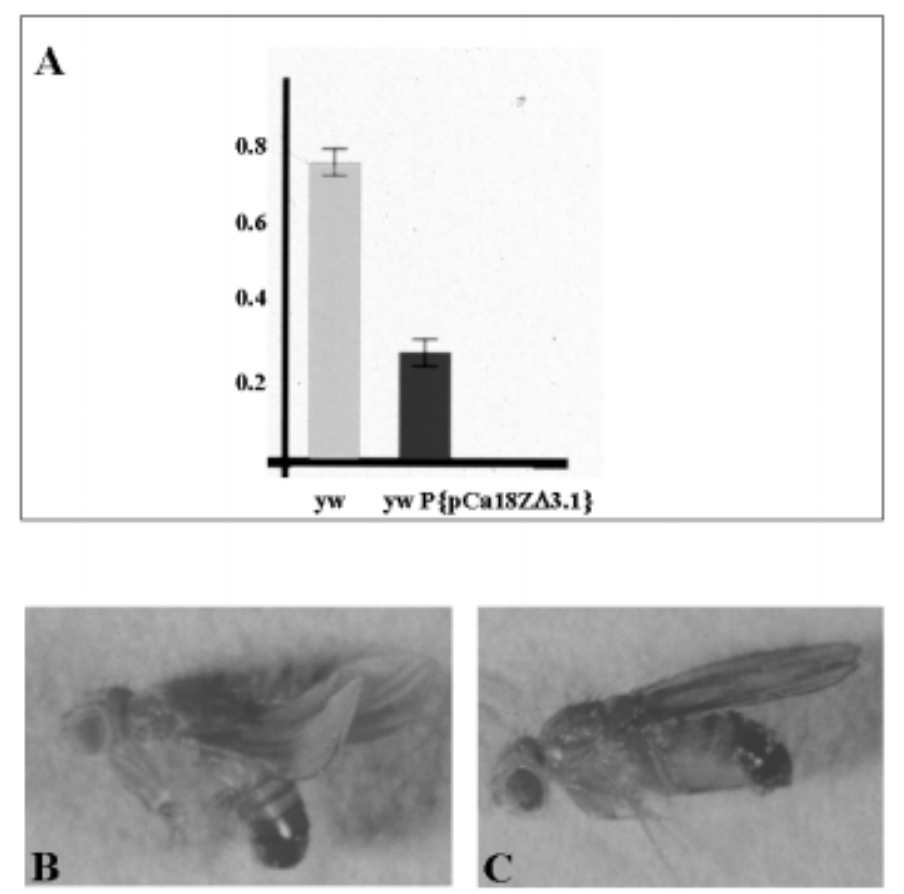
Fig. 1–PhenotypiccharacterizationoftransgeniclinepCa18 (cid:5) 3.1. (A)Viabilityof0-4hembryos heat shocked for 24hs in percentage × 10 − 2 . The parental strain yw 1118 was used as a control. Viability of the transgenic embryos at 25 ◦ C is about 85% of the parental strain (see figure 3). (B) Post embryonic curled wing phenotype of an transgene-carrying individual raised at 30 ◦ C from third instar larval stage to eclosion. (C) wild type